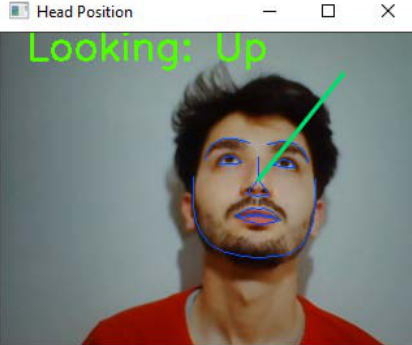
Figure 4 . Face Direction.